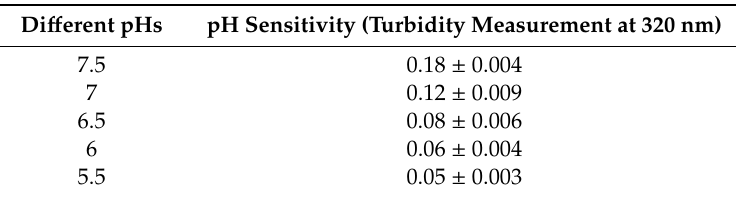
Table 3. pH-sensitive response of GBA in bicarbonated water via turbidity analysis at 320 nm.